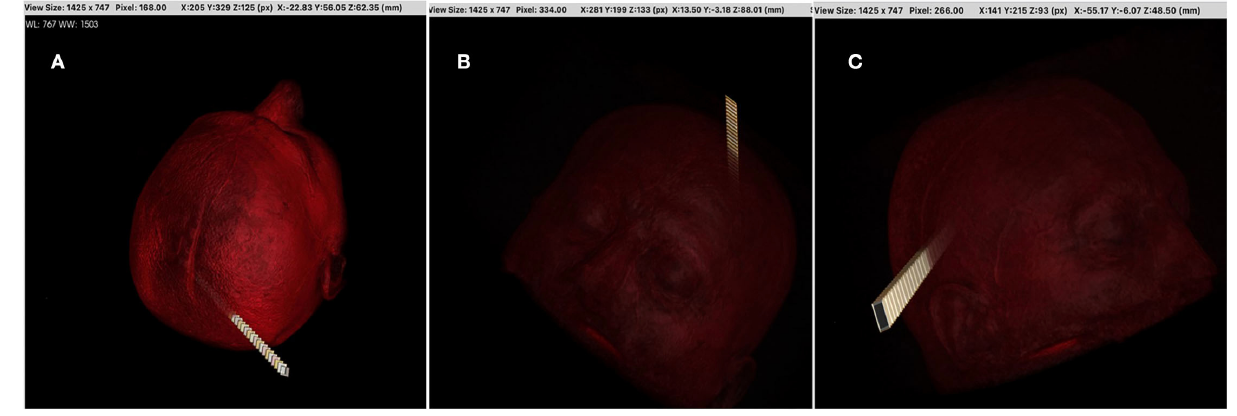
Frontiers in Surgery |